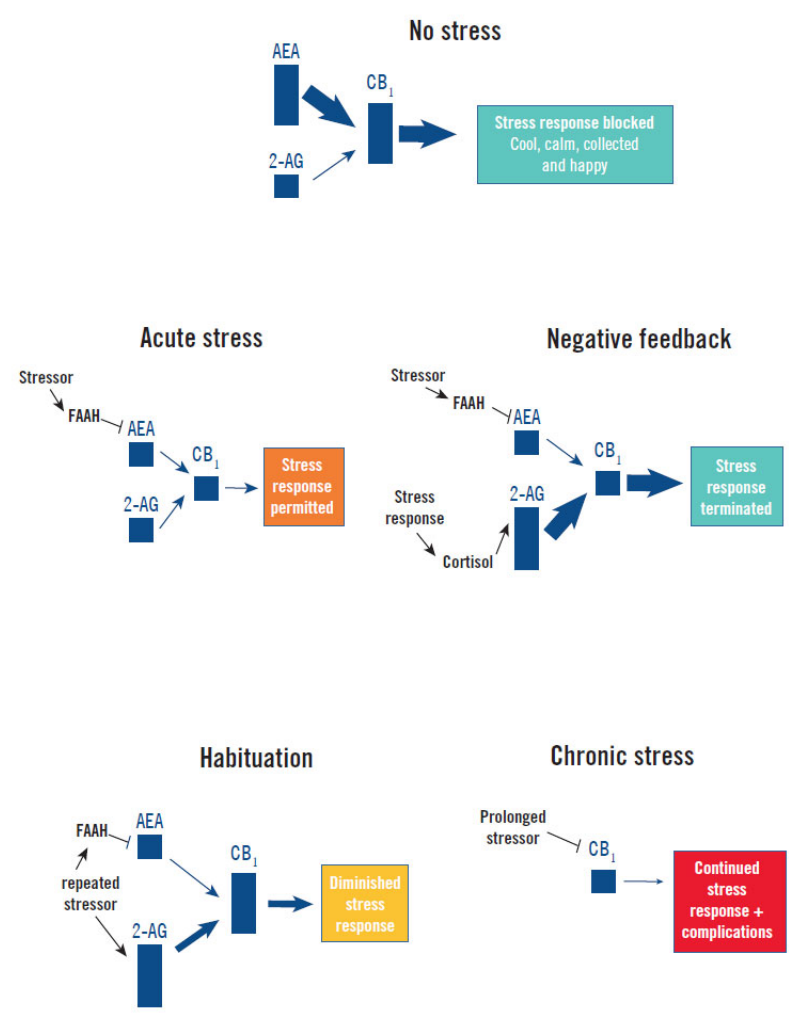
Figure 2. Endocannabinoid regulation of the stress response. Without a stressor (No Stress) basal AEA tone maintains CB 1 signaling constraint of the stress response and a cool, calm, collected, and happy state. Acute presentation of a stressor (Acute Stress) elevates FAAH hydrolysis of AEA, reducing CB 1 signaling and permitting activation of the stress response [13,15,32,39]. Secretion of cortisol by the stress response provides Negative Feedback by increasing 2-AG production, which increases CB 1 signaling and terminates the stress response [15]. Repeated presentation of the same stressor progressively increases 2-AG levels, possibly by reduced MAGL expression and degradation of 2-AG, which causes progressively higher CB 1 signaling and Habituation to the stress response [4,15]. Chronic Stress causes a downregulation of CB 1 that impairs feedback inhibition and facilitates persistence of the stress response and high cortisol levels, which precipitates or exacerbates illness (complications)